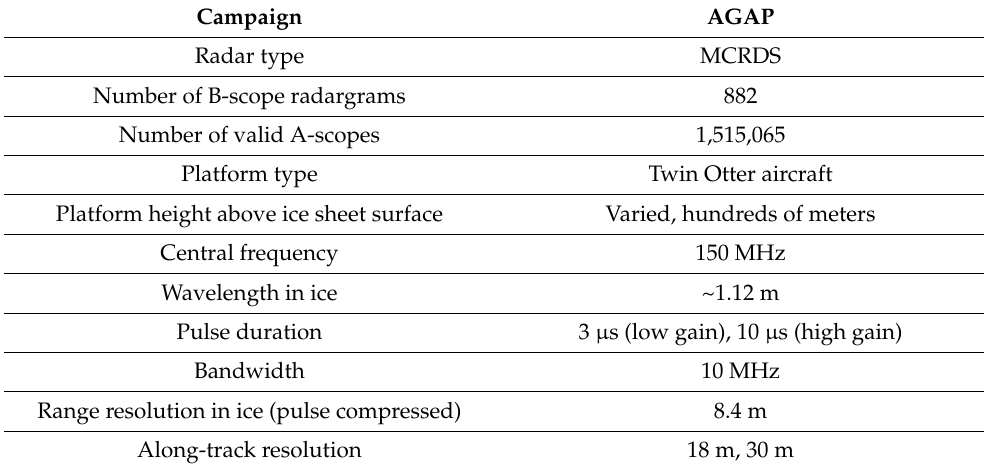
Figure 2. ( a ) The distribution map of the RES B-scope radargram data used in this study in the AGAP region. The red and black lines are designated as the distance between the two adjacent A-scopes, being 18 m and 30 m, respectively. ( b ) The flight lines overlaid the bed elevation data from BedMa- chine Version2 Antarctica [47].